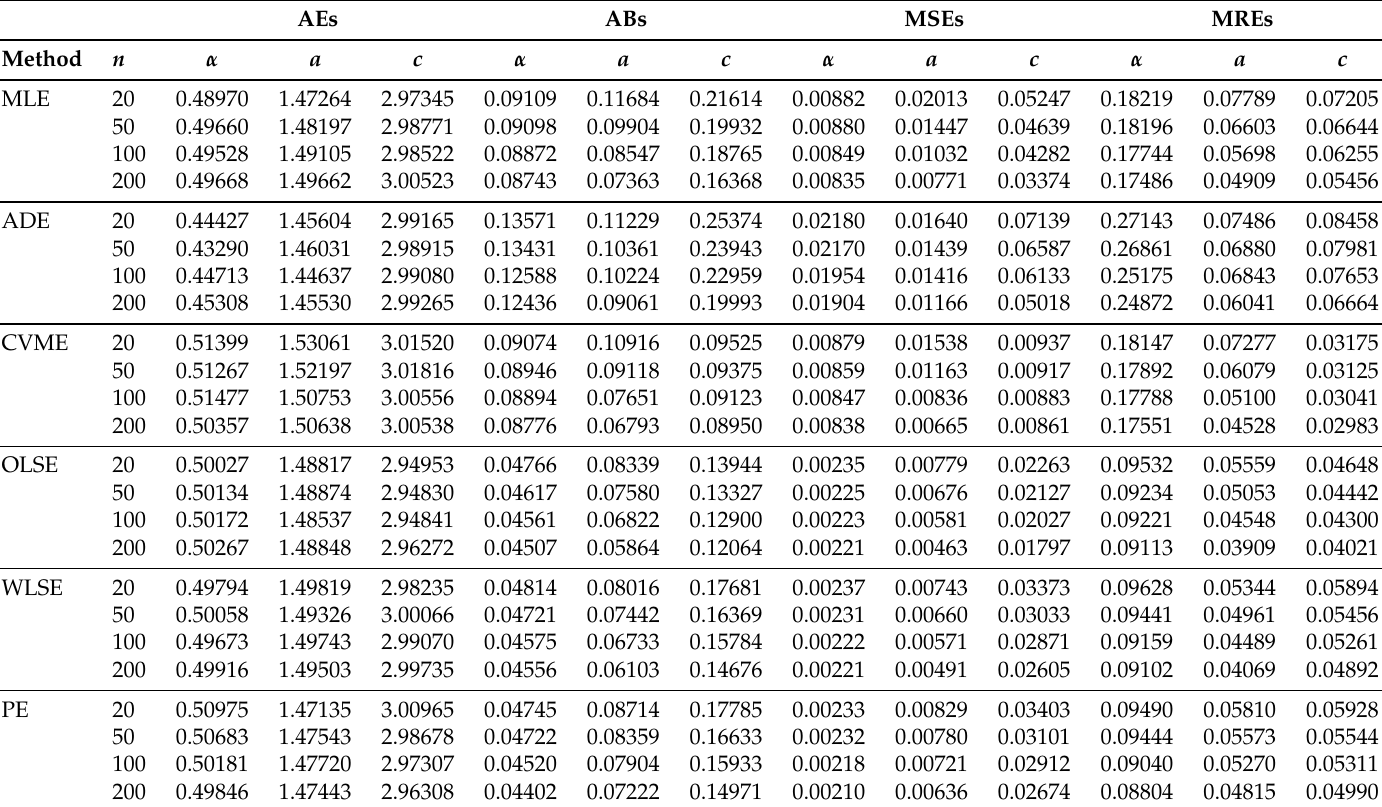
Table A6. The AEs, ABs, MSEs, and MREs for ( α = 0.5, a = 1.5, c = 3 )